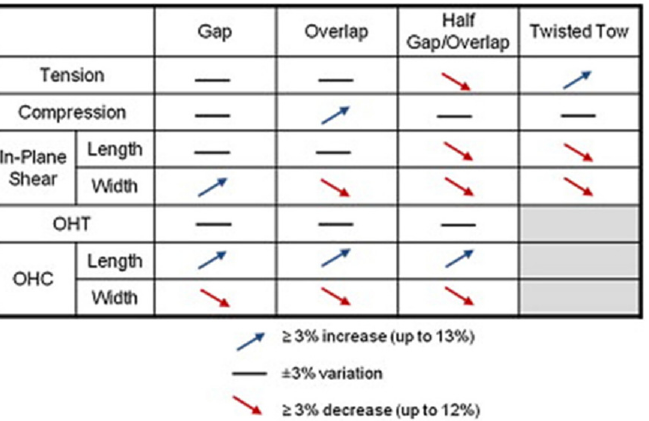
Figure 2. Overview of layup defects on the strength of AFP prepreg laminates, according to [8], OHT (open hole tension), OHC (open hole